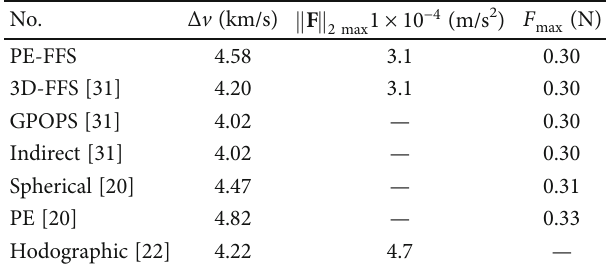
Figure 9: Pro fi les of the optimal thrust acceleration. Table 5: Comparison of the asteroid 1989ML rendezvous mission by di ff erent